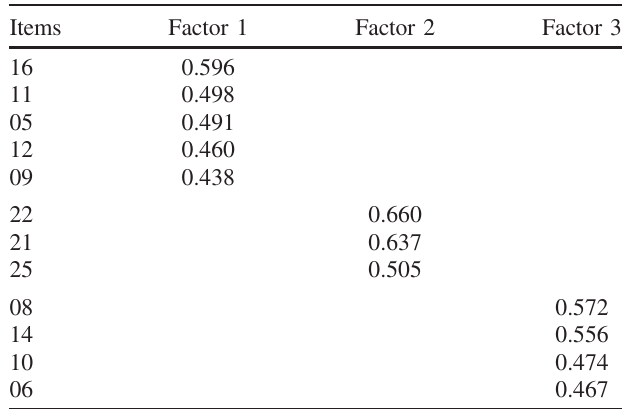
TABLE XI. Finalized factor loadings for group B. Loadings less than 0.25 have been suppressed. EFA involved approxi- mately half of the section 1 students. These loadings represent results after a filtering of the original 30 items and a comparison with group